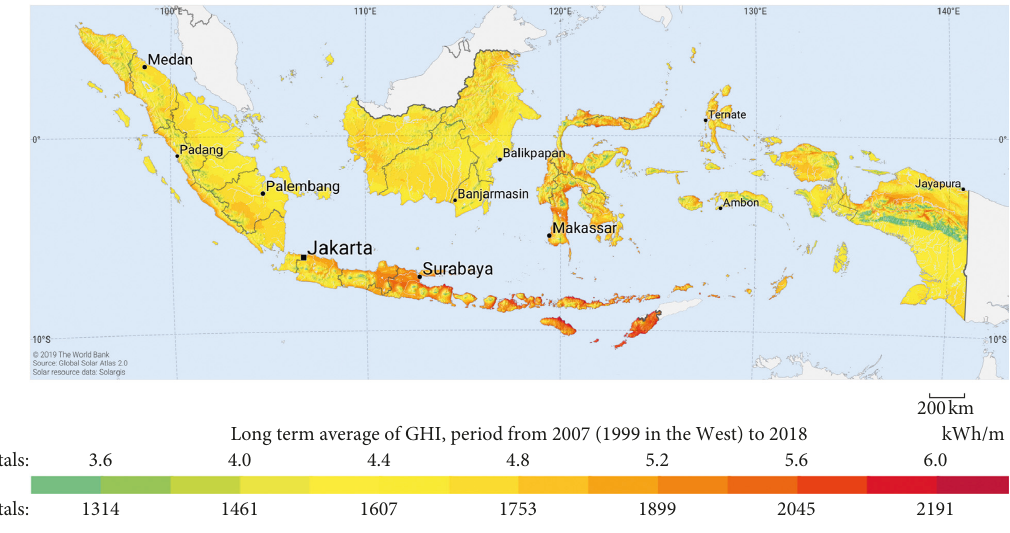
Figure 2: Solar radiation map of the Indonesian area [19].